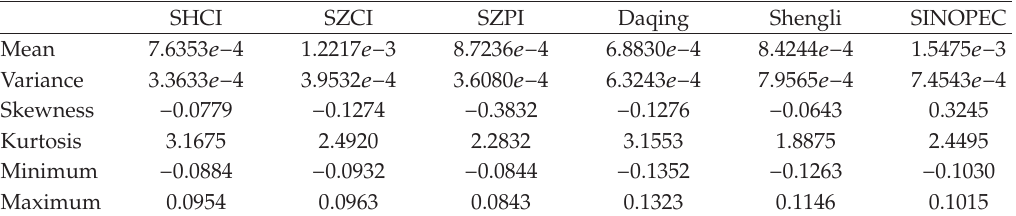
Table 4: Returns statistics of the real